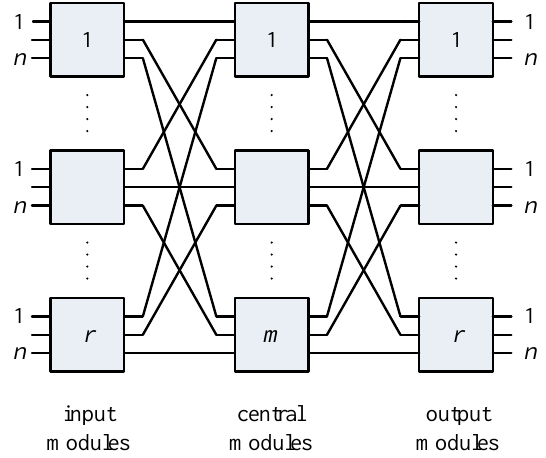
Figure 1. A three-stage Clos switching fabric.